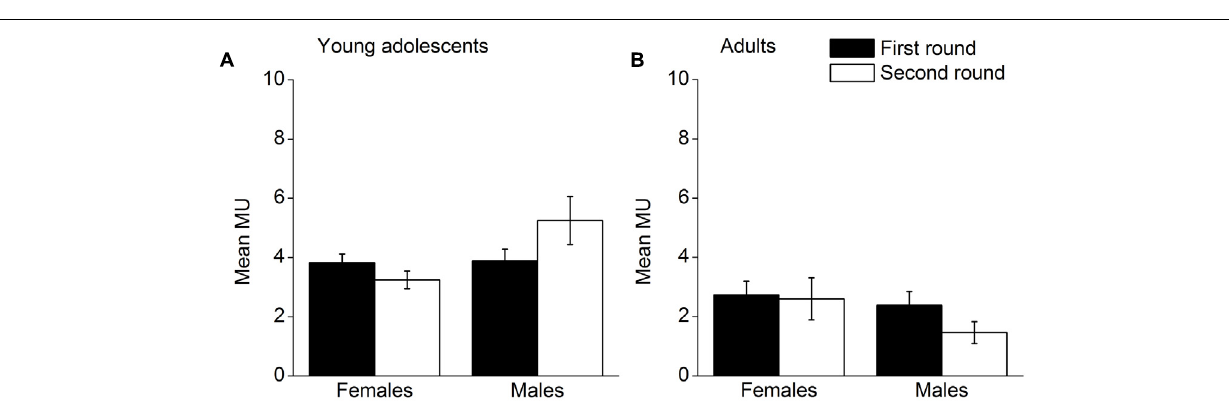
FIGURE 2 | Sharing in the two rounds for males and females; (A) mean MUs adolescent allocators shared, (B) mean MUs adult allocators shared. Error bars represent standard